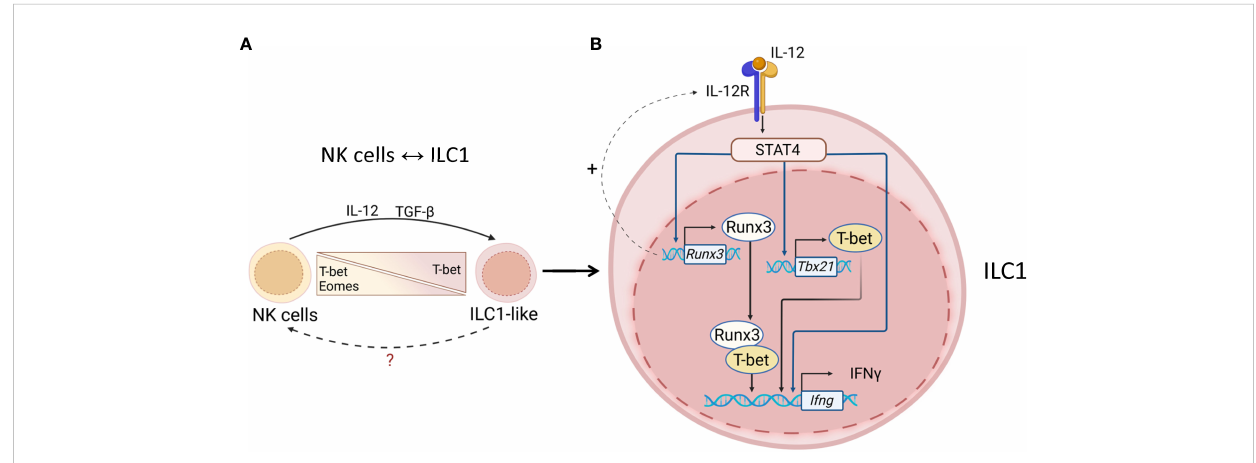
FIGURE 2 Transcriptional regulation of ILC1s and NK cells. (A) NK ↔ ILC1 plasticity. Tumors and mucosal pathogens, such as toxoplasma can induce IL-12 and TGF- b production by DCs and macrophages to drive NK ↔ ILC1 plasticity. NK ↔ ILC1 conversion is controlled by upregulation of T-bet and downregulation of Eomes. The ability of ILC1-like cells to convert back to NK cells remains unknown. (B) Maintenance of ILC1 identity. T-bet is required for ILC1s to produce IFN g . IL-12R signaling activates STAT4, which induces T-bet transcription. Activated STAT4 also binds to Runx3 and IFN g promoters to induce expression. Runx3 can also promote expression of IL12Rb1 thereby amplifying IL-12R signaling. T-bet associates with Runx3 to drive IFN g transcription. IL-12R/STAT4 signaling maintains ILC1 phenotype via inducing T-bet and Runx3 for IFN g